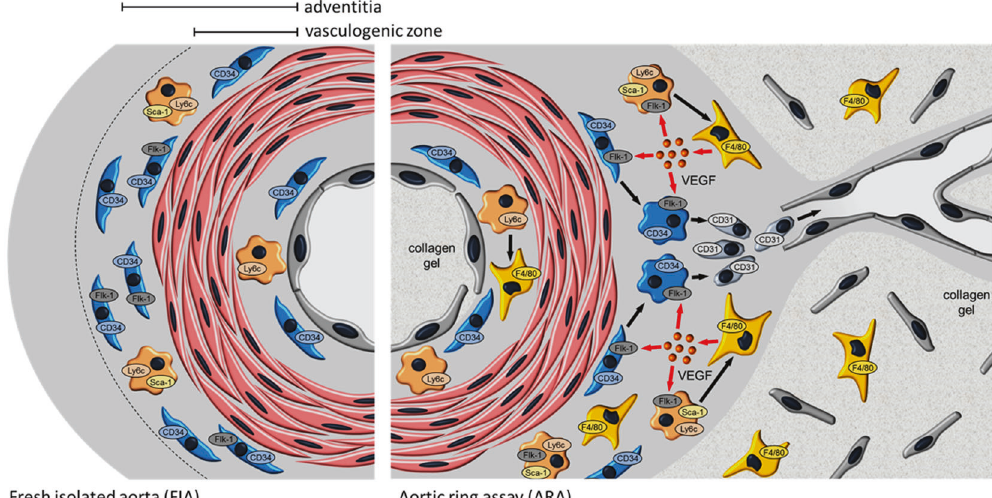
Fig. 7 Interplay of adventitial cells in angiogenic activation. In ARA the majority of macrophages arise from resident bone marrow- independent and at least partially yolk sac-independent Ly6c + /Sca-1 + adventitial progenitor cells. VEGF released by macrophages on the one hand induces angiogenetic sprouting by stimulating the differentiation of CD34 + progenitor cells within the adventitial vasculogenic zone into CD31 + endothelial cells. On the other hand, macrophage-derived VEGF potentiates the generation of macrophages via VEGF/ VEGFR2 signaling in terms of a feedforward loop thereby maintaining the angiogenic process. Cell Death and Disease (2022)